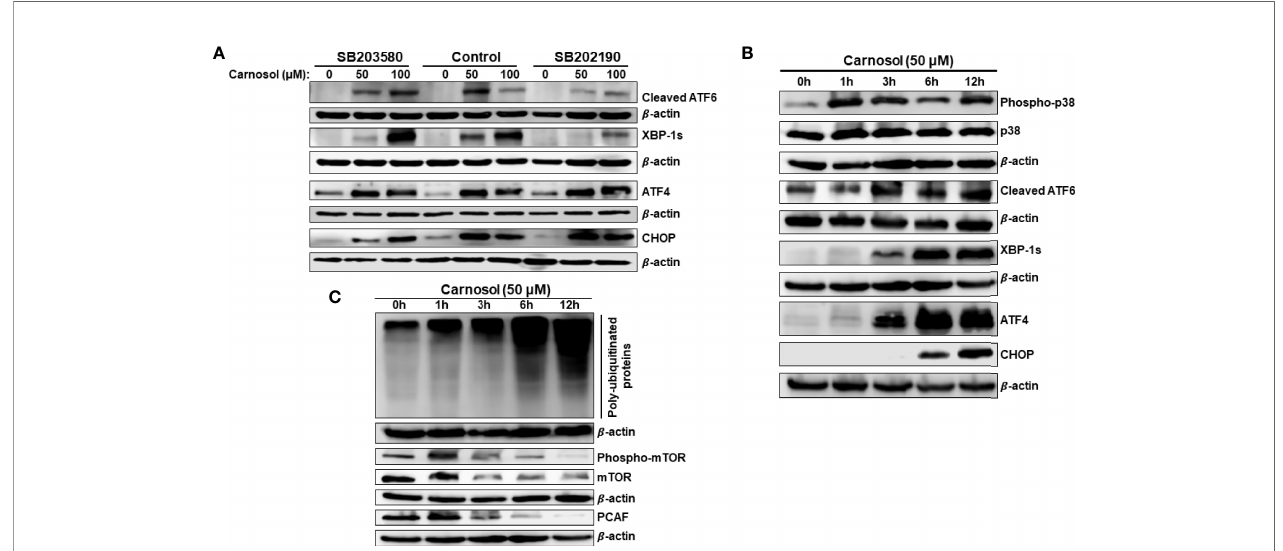
FIGURE 7 | p38MAPK activation of ATF6 and IRE-1 a UPR sensors. (A) Chemical inhibition of p38 blocked the activation of ATF6 and IRE-1 a UPR sensors but did not affect the activation of the PERK sensor. Cells were pre-treated with the p38 inhibitors (SB203580 or SB202190) before adding carnosol (50 µM) for 24 hours. Whole cell lysates were analyzed by Western blot for markers of ER stress (cleaved ATF6, XBP-1s, ATF4, and CHOP). (B) Time-course analysis, by Western blotting, of phospho-p38, total p38, cleaved ATF6, XBP-1s, ATF4, and CHOP. Cells were treated with carnosol (50 m M) and proteins were extracted at the indicated time points (0, 1, 3, 6, 12 hours) as described in Materials and Methods. (C) Time-course analysis, by Western blotting, of phospho-mTOR, total mTOR, and